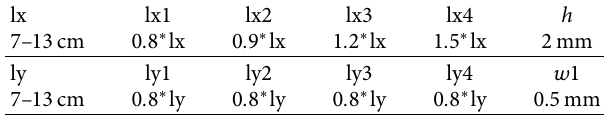
Figure 1: (a) Top view of the unit cell. (b) Side view of the unit cell. Table 1: Parameter values of unit cell geometry.